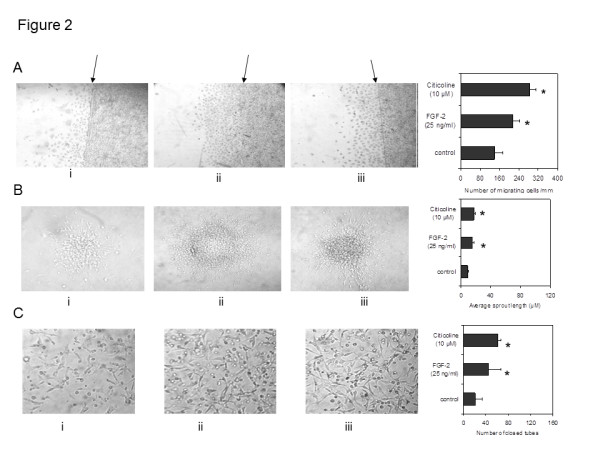
Effects of citicoline on wound recovery, spheroid sprouting and tube-like structure formation in Matrigel. A) a significant increase in the number of migrating cells from a scratch wound was seen in hCMEC 24 h after treatment with FGF-2 (positive control; ii) and citicoline (10 μM; p = 0.015; iii). The bar chart represents the mean numbers of migrating cells from triplicate coverslips of control untreated cells, FGF-2 positive control (25 ng/ml), and citicoline treated cells (10 μM). B) Shows that addition of citicoline (10 μM) significantly increased the formation and intensity of spheroids as well as migration of cells outwards from the central mass after 7 days incubation (P = 0.005; iii). The bar chart represents the mean sprout length of control spheroids after 7 days, FGF-2 (25 ng/ml), and Citicoline 10 μM. Values are expressed in μM and at least 10 spheroids from each condition were analyzed. C) When cells were cultured in Matrigel™ in the presence of citicoline for 24 h, a significant increase in the formation of tube-like structures was observed compared with control cells (p = 0.010; iii). The bar graphs and photomicrographs shows control cells, cells treated with FGF-2 (25 ng/ml), cells treated with citicoline (10 μg/ml). The data illustrates the significant increase in the numbers of closed-loop areas in the presence of citicoline (p = 0.010). Five areas from each well and 3 wells per treatment were analyzed.